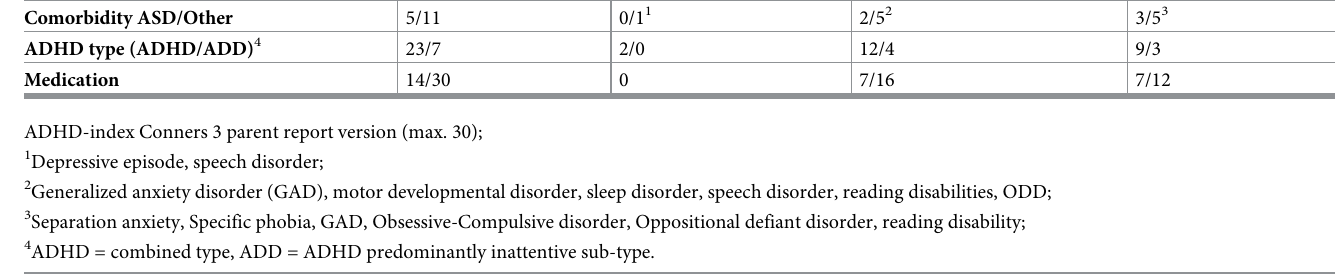
(left) and reference (right). In addition, four electrodes were placed around the eyes to measure the vertical and horizontal electrooculogram (EOG). Ag/AgCl electrodes were used at all sites, and impedance was kept under 5k Ohm. Prior each session the subjects eye movements were calibrated for an online correction, eliminating or suppressing signals from the eyes. Signal changes that exceed 200 μ V, where automatically rejected and retaken, as these indicated artifacts.